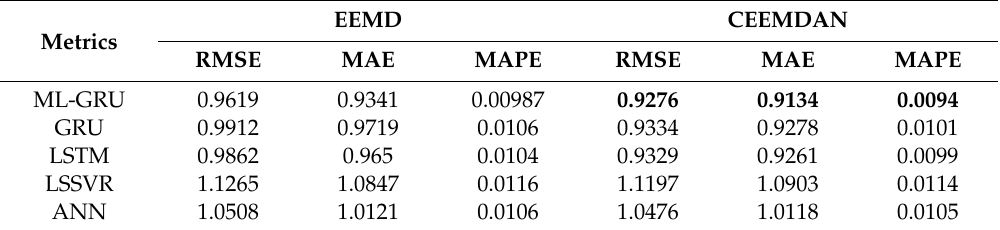
Table 6. The experimental results in terms of hybrid approaches on WTI crude oil prices forecasting.